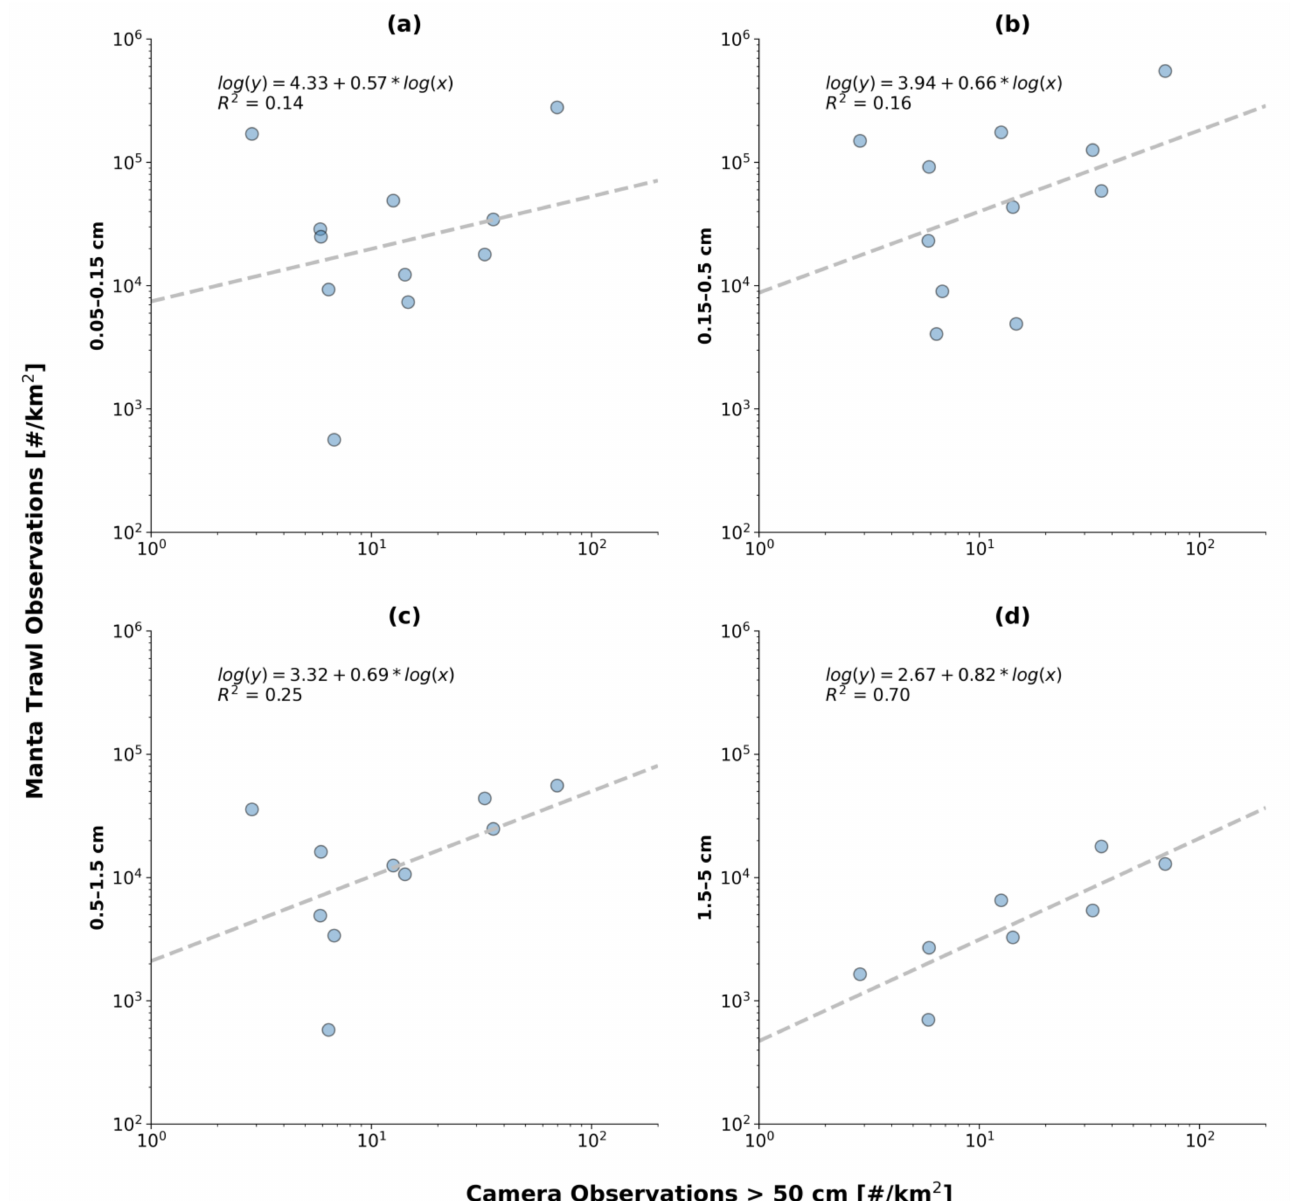
Figure 11. Log-Log scatterplots of Manta trawl observations (y) versus camera observations (x), defined in Section 2.5, for four different Manta trawl size classes: ( a ) 0.05 cm (lower limit)–0.15 cm, ( b ) 0.15–0.5 cm, ( c ) 0.5–1.5 cm, and ( d ) 1.5–5 cm (upper limit). The text in the upper left corners expresses the linear regression model of each subplot’s log-transformed values and the model’s coefficient of determination (R 2 ) value. The gray dashed lines indicate the fitted regression